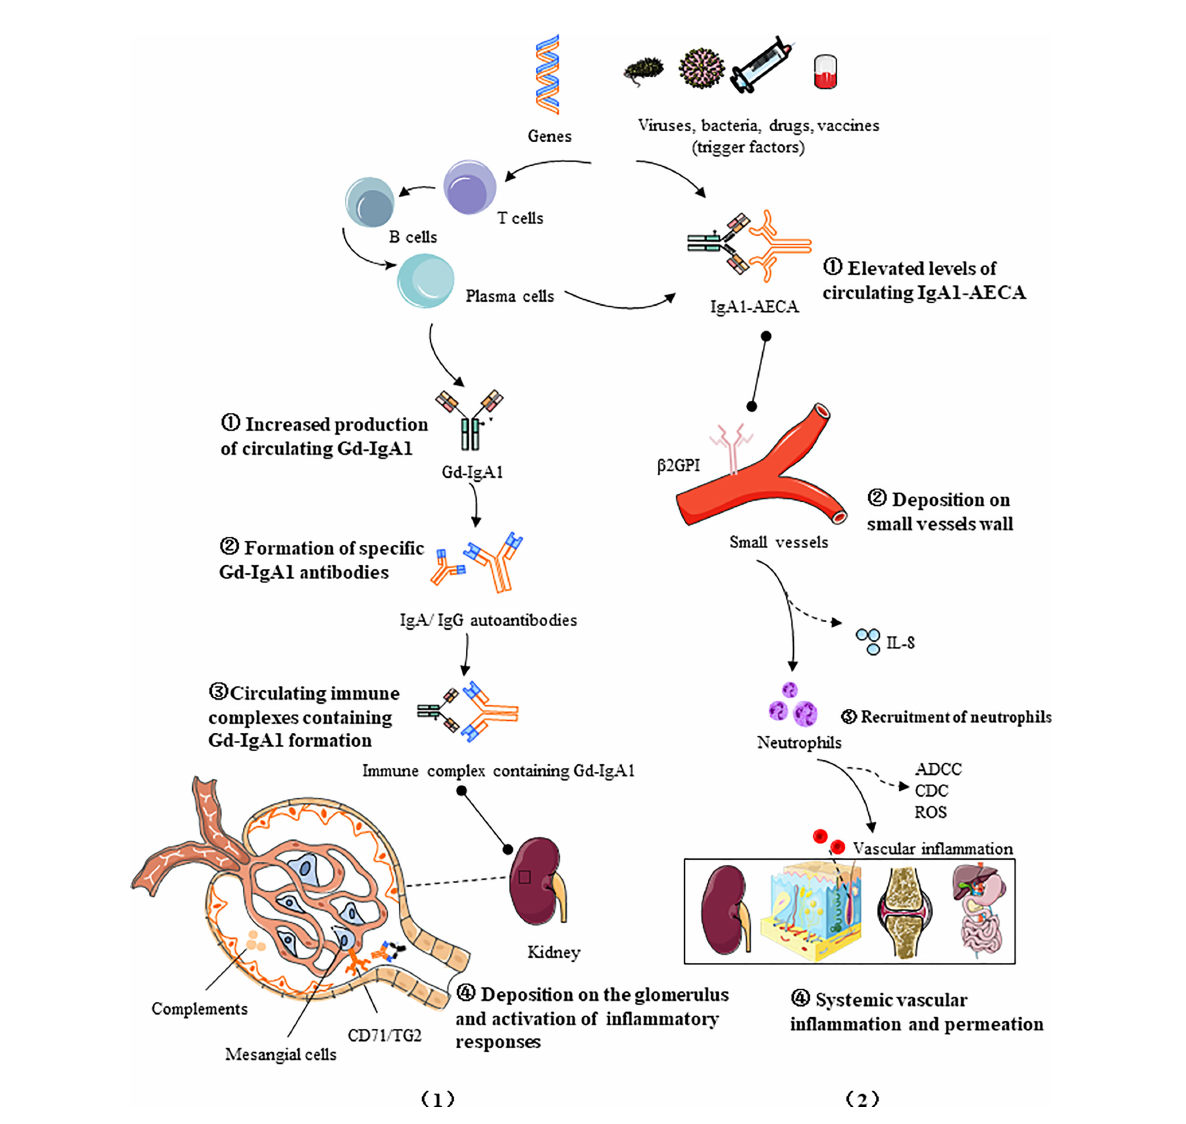
FIGURE 1 Two four-hit pathogenesis models for IgAV: (1) Increased production of circulating galactose-de fi cient IgA1 (hit1) binds to speci fi c IgA1 autoantibodies (hit2), forming pathogenic circulating immune complexes (hit3), which then deposited in the glomerulus and trigger in fl ammatory responses (hit4); (2) The fi rst hit is provided by elevated AECA levels of IgA1 isotype, followed by the binding of IgA1-AECA complexes to speci fi c b 2 glycoprotein I receptors ( b 2GPI) on vascular endothelial cells (hit2), inducing excessive production of proin fl ammatory factors such as IL-8, which in turn stimulates neutrophil recruitment (hit3), and then the activation of causes extensive damage to the vascular endothelium via antibody-dependent cellular cytotoxicity (ADCC), complement-mediated cytotoxicity (CDC), and reactive oxygen species (ROS), ultimately leading to systemic vascular in fl ammation and permeation (hit 4). The pathogenic processes of IgAV are promoted by immune cells and in fl ammatory mediators and regulated by multiple factors, including genetics and the